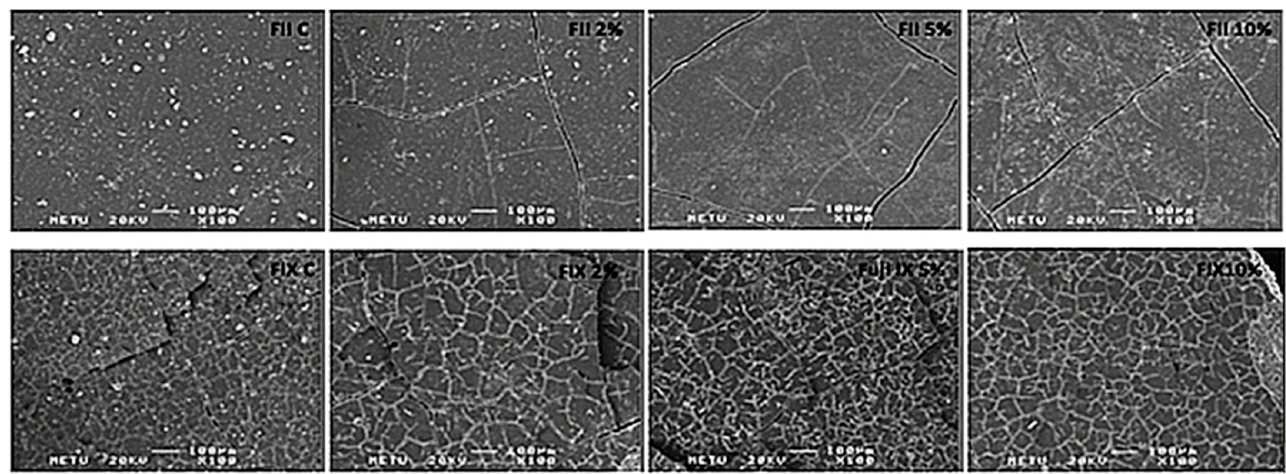
Figure 1. Representative SEM photomicrographs (×100 magnification) of a Fuji II (first row): Fuji II (without HA particles), Fuji II 2 wt % HA, Fuji II 5 wt % HA, Fuji II 10 wt % HA respectively; and Fuji IX (2nd row): Fuji IX (without HA particles),